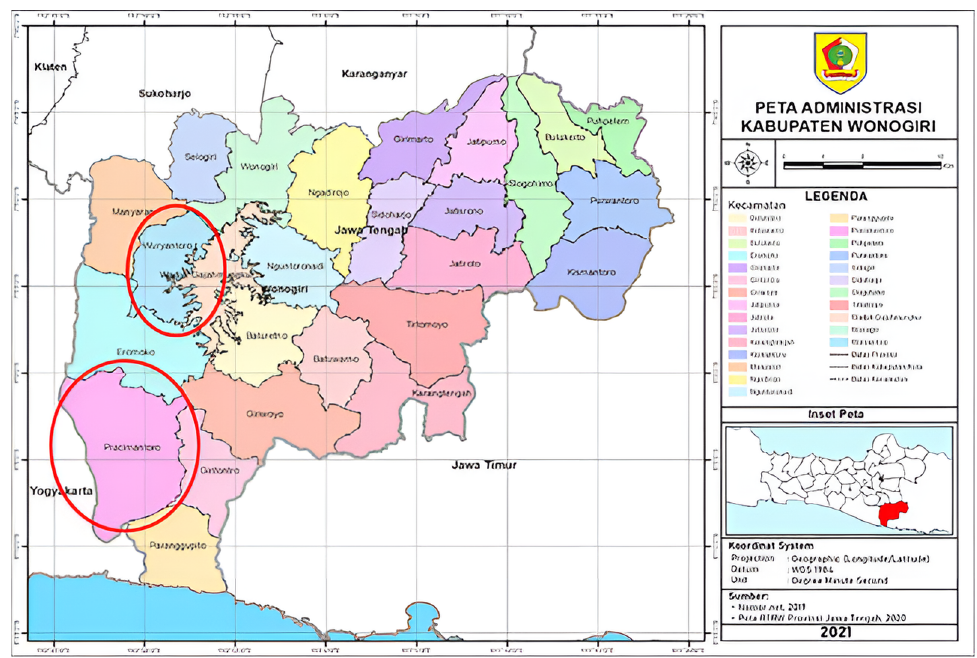
Figure 1. Wuryantoro and Pracimantoro Sud-District, Wonogiri Regency, Central Java. (Data from: Ahmad